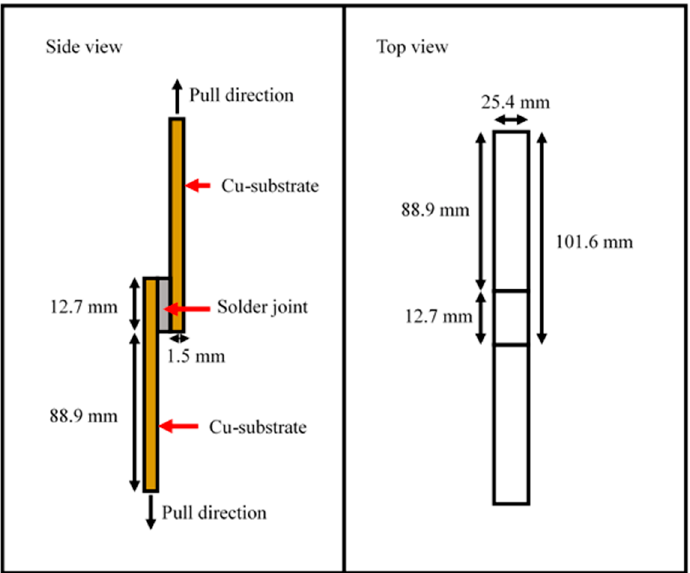
Figure 3. Schematic diagram of Sn-0.7Cu solder joint sample for lap-shear test.